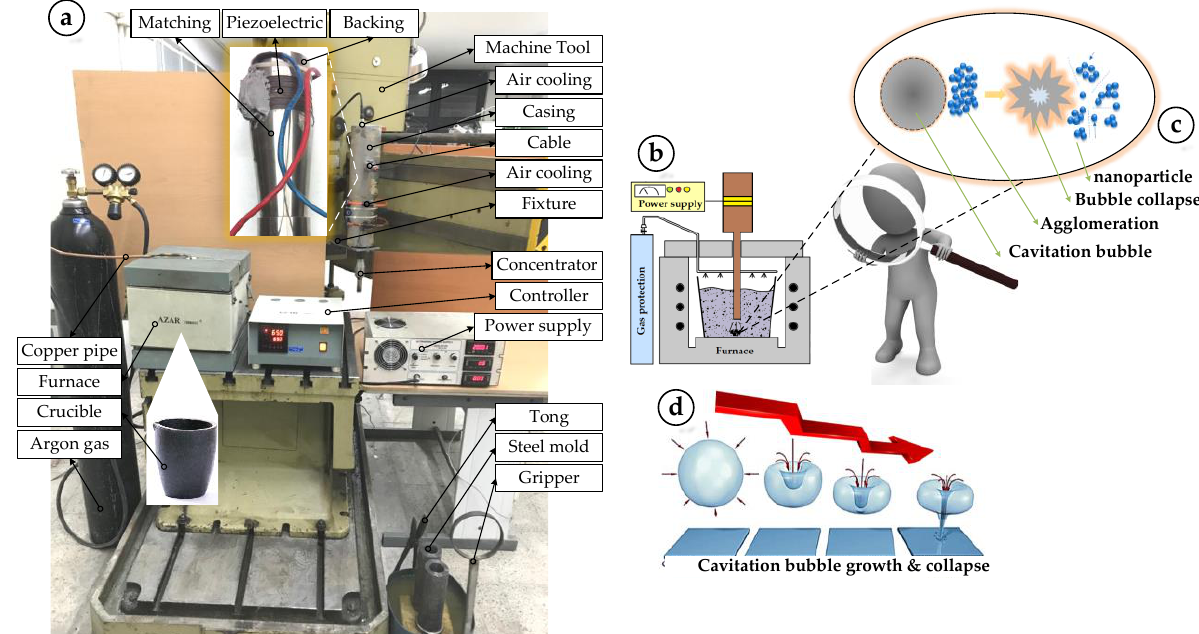
Figure 2. ( a ) The experimental setup to fabricate ultrasonically stir cast SiO 2 /A356 nanocomposites with ( b ) schematic ultrasonic dispersion of reinforcing particles in a molten metal, ( c ) wherein the ultrasonic bubbles are severely squeezed, and then collapse to facilitates high-intensity shock waves. The streaming flow patterns will generate when the bubbles are squeezed enough and collapsedto produce shock waves ( d